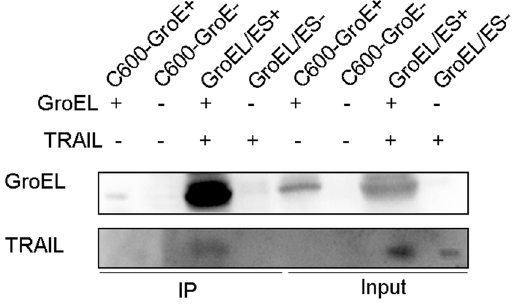
Figure 3. Interaction between GroEL and TRAIL. Strains C600-GroE + and C600-GroE − , both constructed in E. coli C600, overexpressed GroE and were GroE-deficient, respectively. GroEL/ES + and GroEL/ES − correspond to C600-GroE + and C600-GroE − transformed with the pBV-TRAIL plasmid, respectively. Lysates from different E. coli strains were pre-incubated with an anti-GroEL antibody and subsequently bound to protein A/G agarose resin. Samples were eluted with 1 × SDS-PAGE loading buffer and subjected to Western blotting with antibodies against GroEL and TRAIL. Samples prepared before and after the co-IP assay are designated input and co-IP, respectively. The cell lysates used for co-IP are presented at the top. The antibodies used for Western blotting are shown on the left.